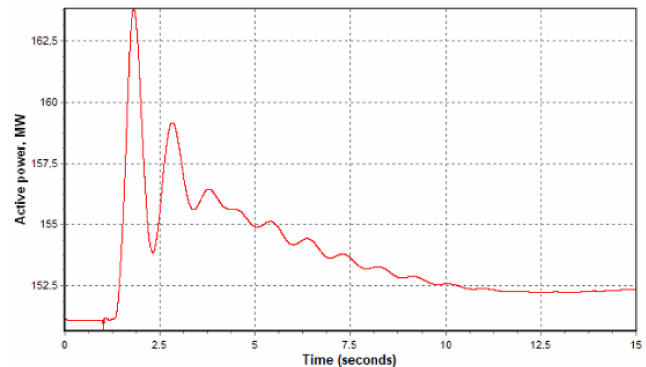
Figure 19. Response of the HVDC BtB converter to SC disconnection.